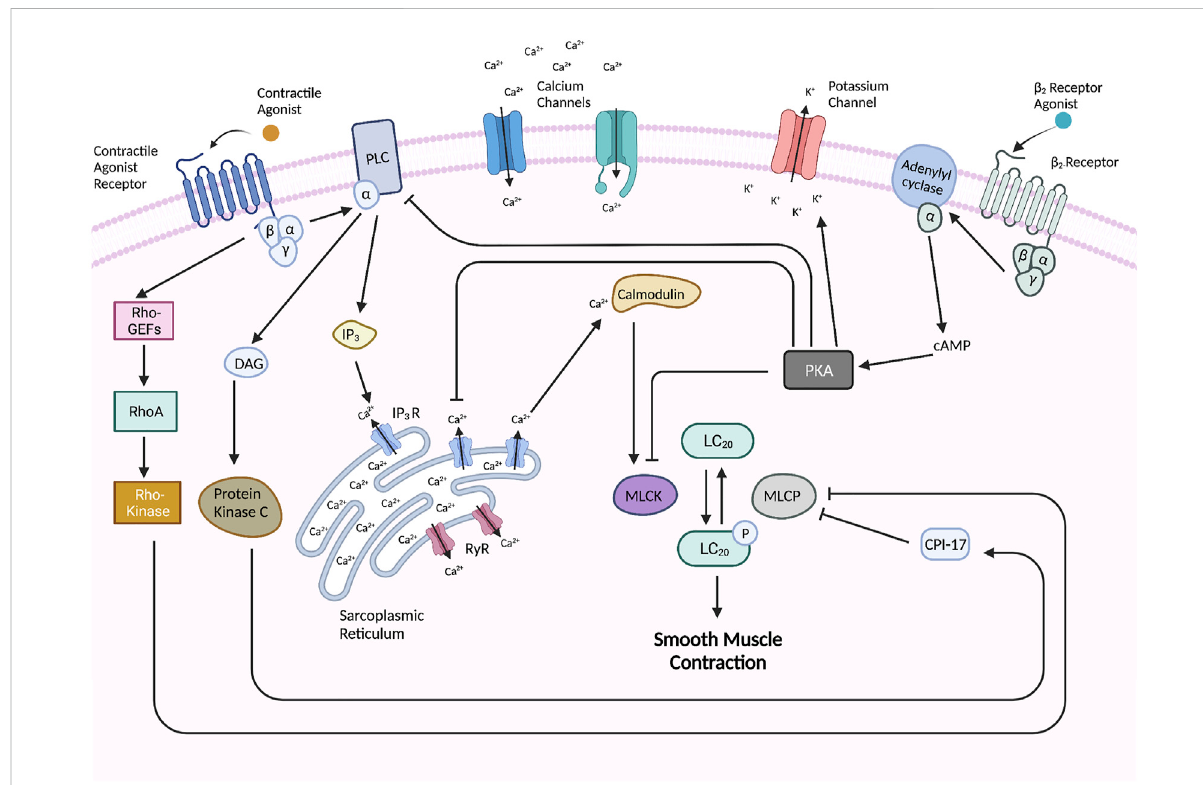
FIGURE 2 Molecular pathways underlying ASM contraction and relaxation. The activation of G-coupled protein receptors such as muscarinic and histamine receptors leads to subsequent interaction and activation of phospholipase C (PLC) which promotes the hydrolysis of phosphatidylinositol 4,5-bisphosphate(PIP 2 )intoinositol1,4,5-trisphosphate(IP 3 )anddiacylglycerol(DAG).IP 3 interactswithIP 3 -gatedchannelsontheSRtoinduceCa 2+ ef fl ux into the cytoplasmic space. Ryanodine receptors (RyR ’ s) on the SR also become activated to release Ca 2+ . In the cytoplasmic space, Ca 2+ binds to calmodulin (CaM) which activates it so that it may activate myosin light chain kinase (MLCK) which phosphorylates and activates the myosin regulatory light chain (LC 20 ) of myosin to initiate cross-bridge cycling and thus muscle contraction. LC 20 is dephosphorylated and thus inhibited by myosin light chain phosphatase (MLCP), but this dephosphorylation is inhibited by two pathways – including the Rho-kinase pathway which is stimulated by the activated GPCR and a CPI-17 pathway which is activated by protein kinase C. Muscle relaxation can be induced by stimulation of a β 2 -receptorwhichleadstotheactivationofadenylylcyclase(AC)whichcatalyzestheformationofcyclicAMP(cAMP).cAMPbindsandactivatesPKA whichcarriesoutvariousregulatoryactivitiessuchasinhibitingMLCK,PLC,andIP 3 -gatedchannels,andactivatingCa 2+ -gatedpotassiumchannelsin the cellular membrane to release K + which hyperpolarizes the cell. Created with